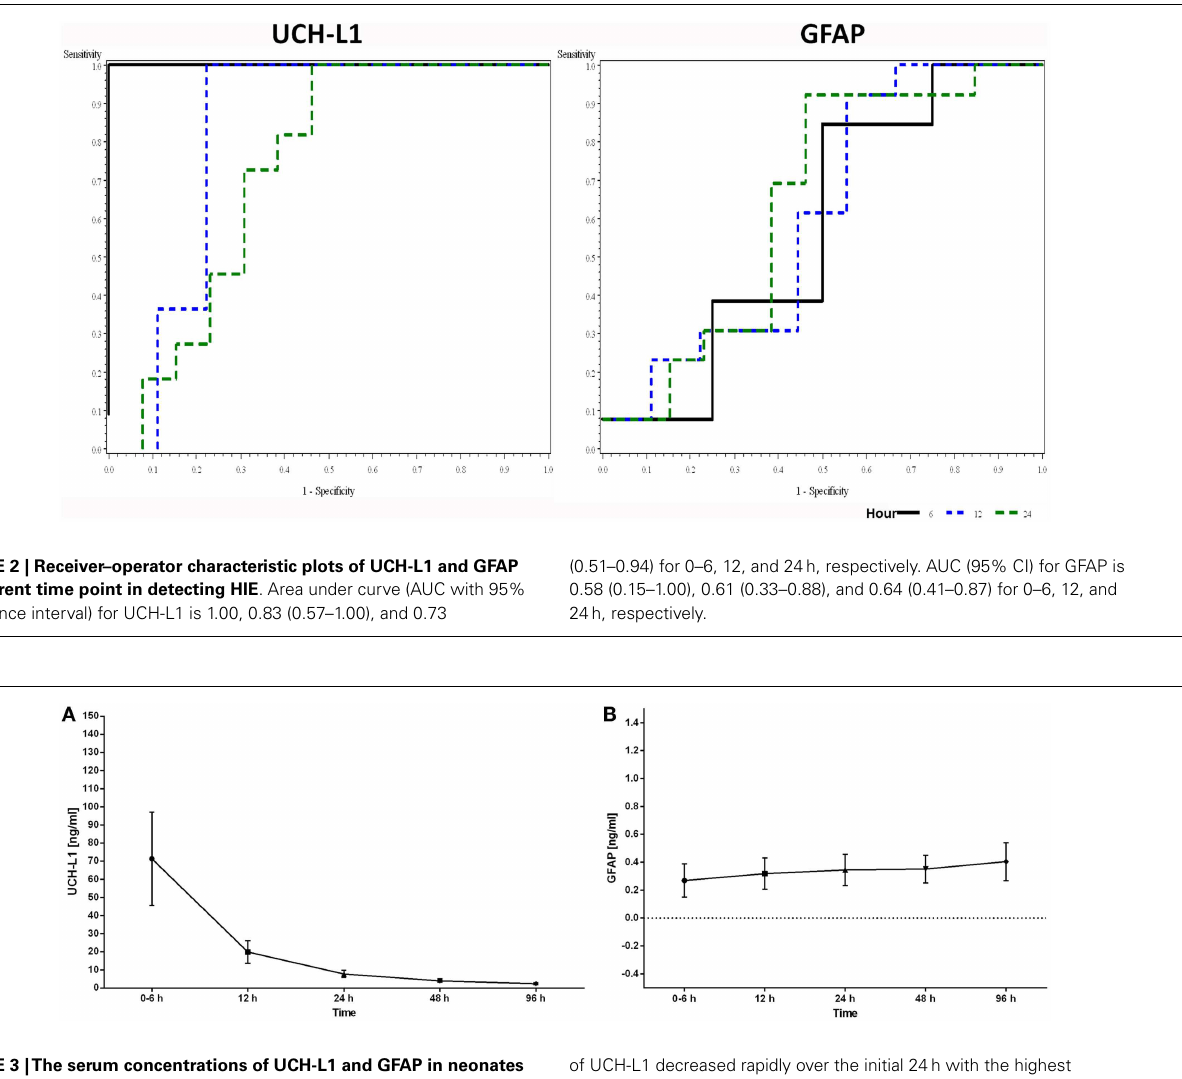
FIGURE 3 |The serum concentrations of UCH-L1 and GFAP in neonates with HIE are plotted over the time of sample collection .The serum concentrations are expressed as the mean ± SEM.The serum concentration